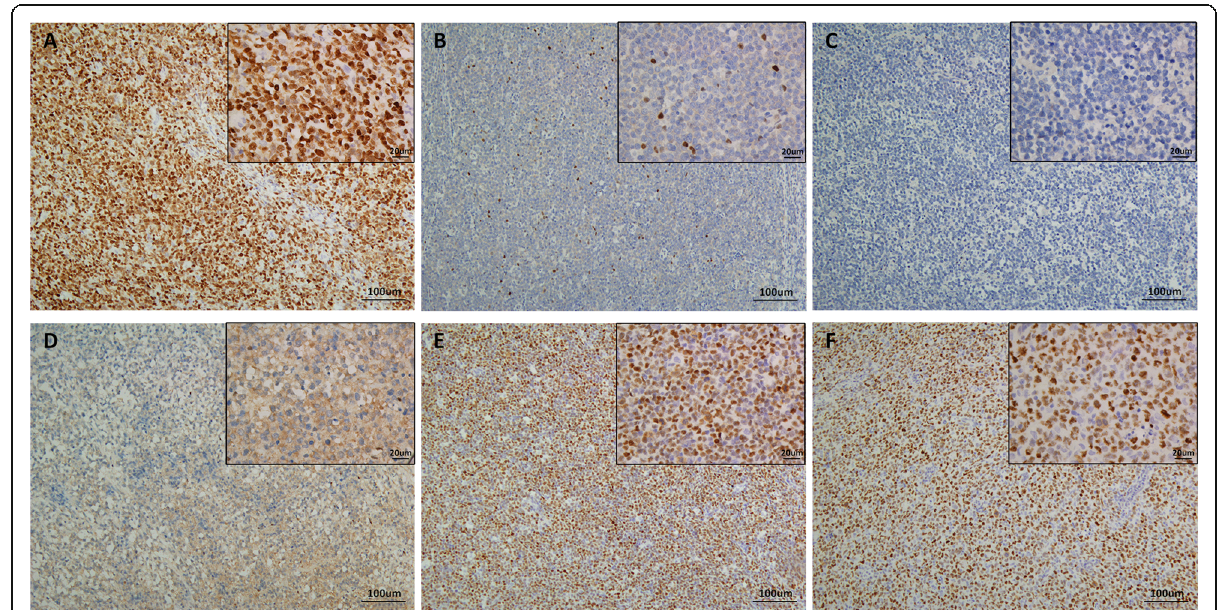
Fig. 1 Representative figure of IHC staining with an anti-P63 antibody of strong expression ( a ), week expression ( b ), no expression ( c ), anti-P40